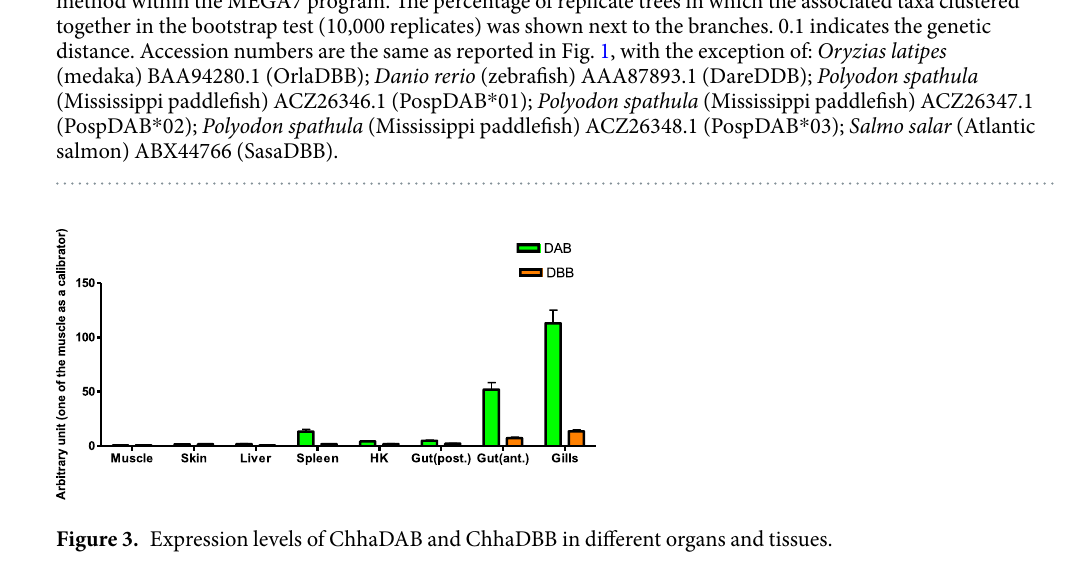
Figure 3. Expression levels of ChhaDAB and ChhaDBB in different organs and